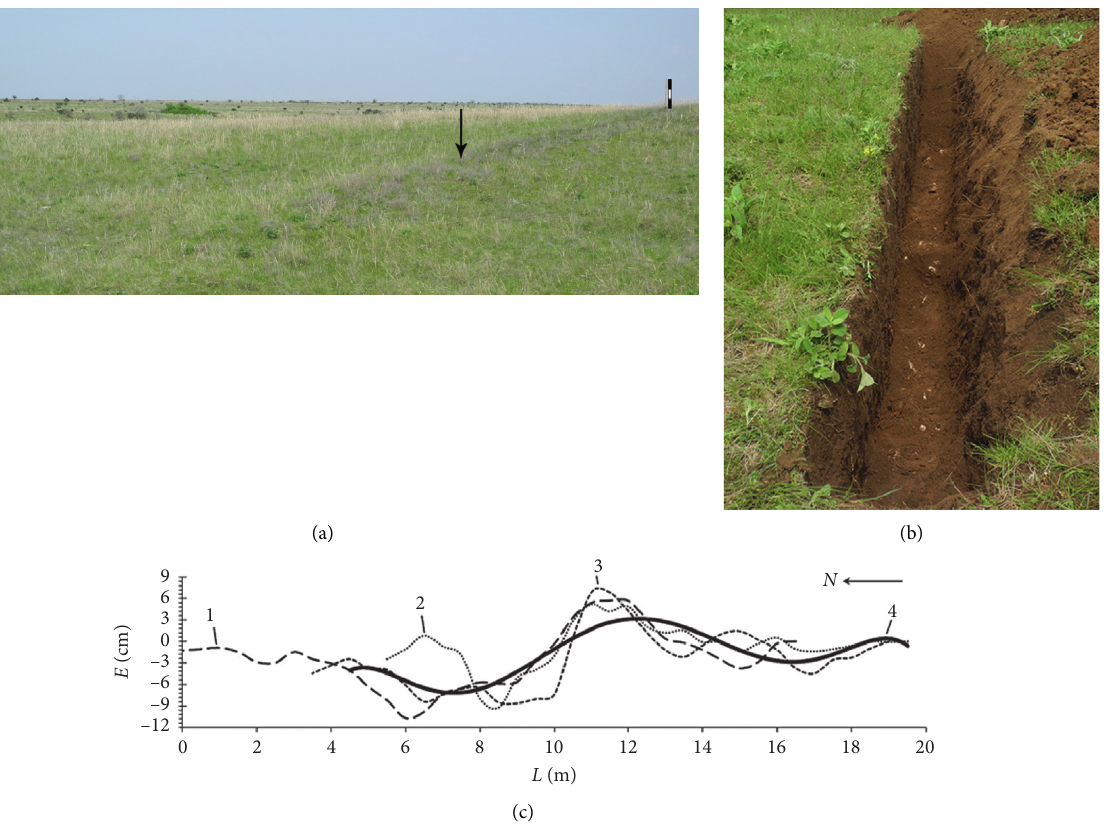
Figure 2: ( a ) Western part of wall R2. (b) Section through wall R2. (c) Combination of geodesic profiles of walls R2 (1), R3 (2), R4 (3), and a polynomial trend (4). F : relative excess along the length ( L ) of the trench. The location of the walls is shown in 1(a) and